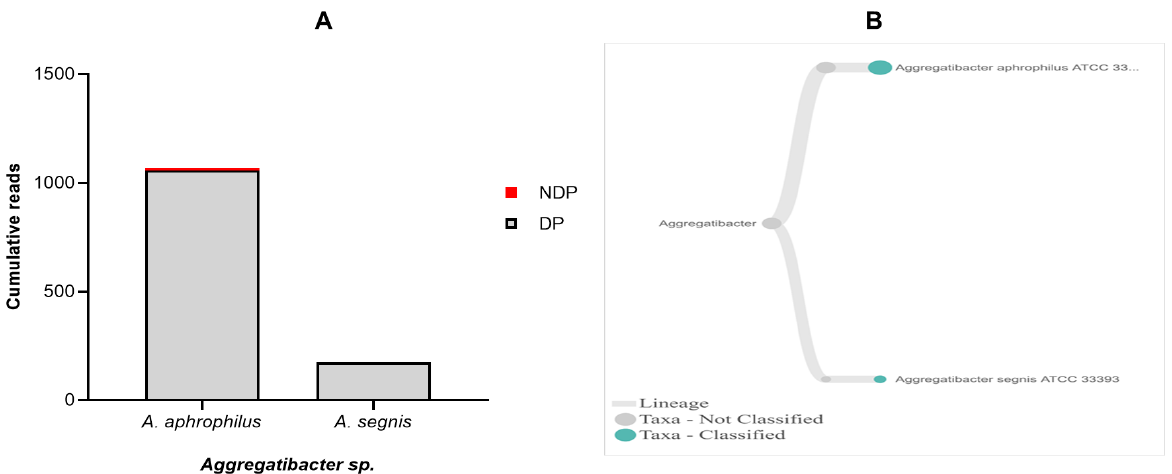
Figure 5. Aggregatibacter sp. in pooled subgingival microbiota samples obtained from diabetic (DP) and non-diabetic (NDP) patients. ( A ) Abundance of Aggregatibacter sp. ; ( B ) dendrograms showing the same Aggregatibacter sp . across pooled samples.